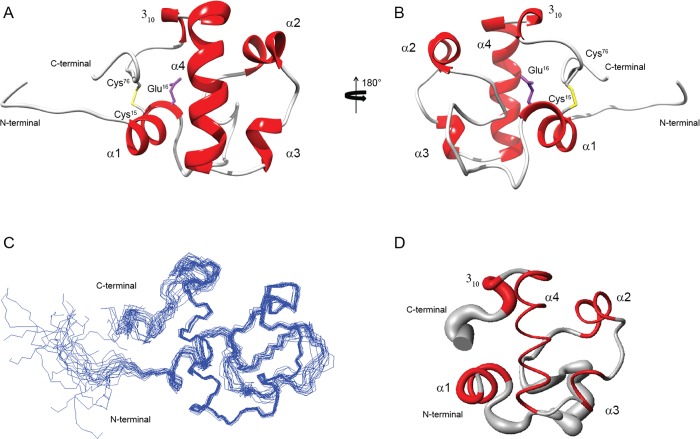
NMR solution structure of RpfCc.(A,B) Ribbon drawing of one representative conformer of the RpfCc NMR structure in two orientation rotated by 180° around z-axes. (C) Overlay of the 20 lowest energy structures of RpfCc. (D) Sausage representation of the RpfCc globular domain (9–78).